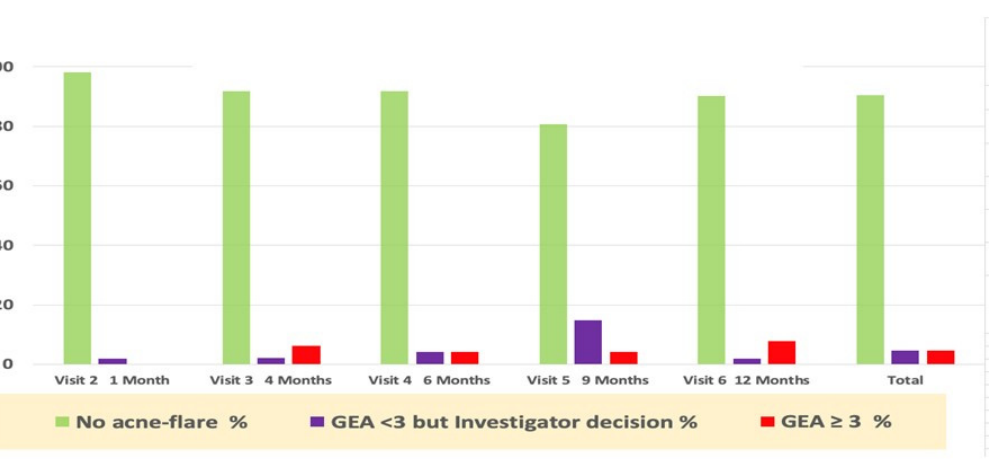
Figure 3. Percentage of subjects with acne flare-ups and prescription drug use during the study.